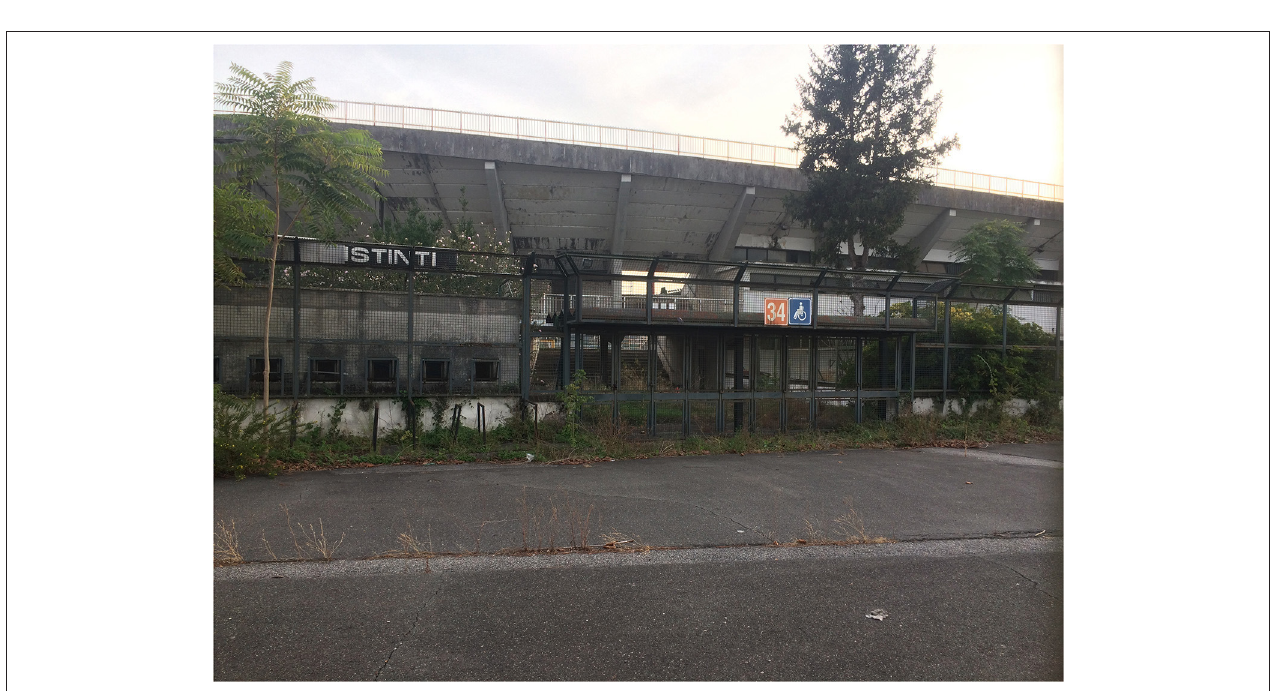
FIGURE 2 | Closed and abandoned: Outside the gates of Stadio Flaminio in September 2017 (Credit: Even Smith Wergeland).